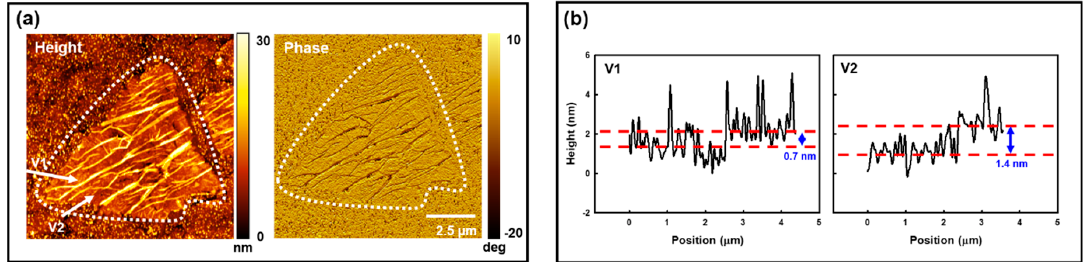
Figure 1. Typical AFM results for a WS 2 flake on TSG. ( a ) Typical AFM height ( left ) and phase ( right ) images. The dotted curve is used to outline the WS 2 flake. Two vectors (V1 and V2) are shown in the height image. ( b ) Typical height profiles along the V1 ( left ) and V2 ( right ) vectors shown in panel a. The V1 and V2 vectors traverse largely single- and two-layer regions, respectively.